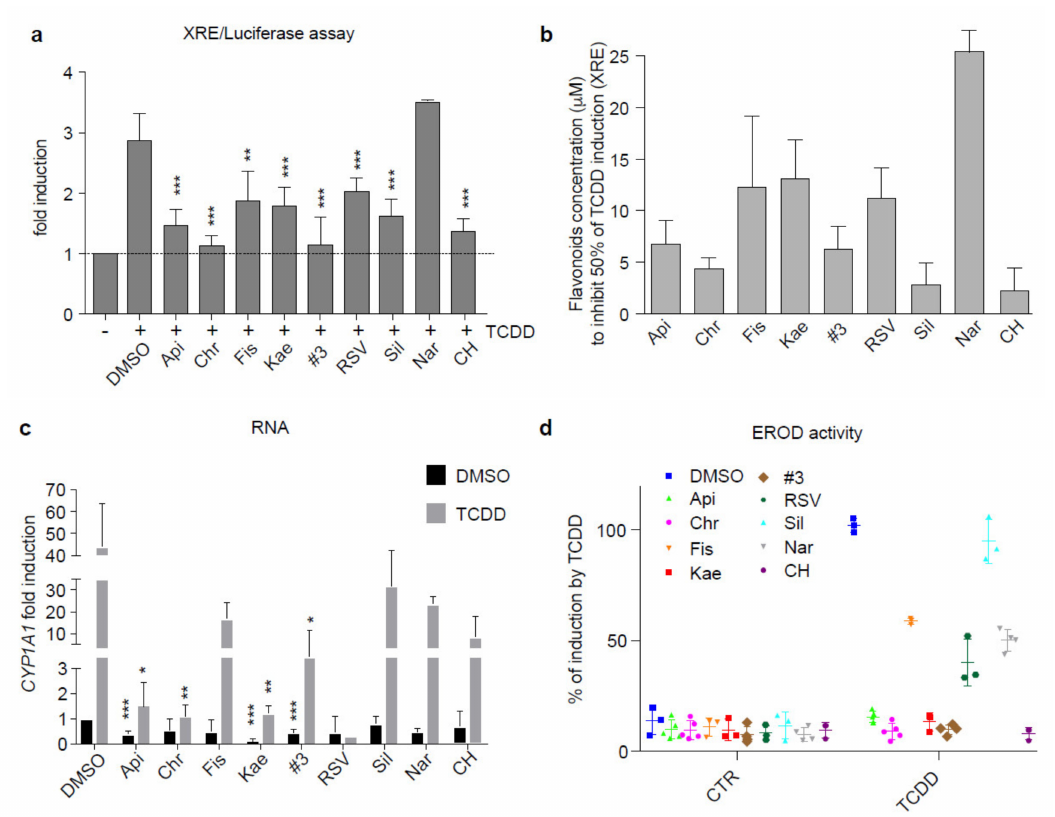
Figure 2. Flavonoids act as AhR antagonists against its canonical activity. ( a – d ) Flavonoids antagonize the canonical AhR activity induced by TCDD (dioxin). ( a ) Evaluation of AhR transcriptional activity related to AhR / ARNT binding sites (XRE) using p3XRE-luciferase constructs. 501Mel cells were exposed to 10 nM TCDD alone or in combination with flavonoids 10 µ M (pretreated for 2 h) for 6 h ( n = 3). ( b ) 501Mel cells were transfected with the p3XRE-luciferase construct and induced simultaneously with TCDD (10 nM) and increasing doses of flavonoids or CH-223191 to compete with AhR agonist. The histogram shows the required concentration of flavonoids to inhibit 50% of the XRE luciferase activity induced by TCDD ( n = 3). ( c ) Flavonoids prevent the induction of CYP1A1 mRNA expression by TCDD. 501Mel cells, pretreated or not with flavonoids (10 µ M, 2 h), were incubated or not with 10 nM TCDD 15 h ( n = 3). ( d ) MCF-7 cells were either untreated or treated with 10 nM TCDD or 10 µ M flavonoids for 6 h. The ability of the flavonoids to prevent TCDD-induced EROD activity was measured ( n = 3). Data correspond to the mean +/ − s.d. of three independent experiments. Statistical analysis was performed using an unpaired t-test (PRISM8.0 ® ) * p < 0.05, ** p < 0.01, *** p < 0.001. # 3 = Mix of apigenin, chrysin, and fisetin (10 µ M final